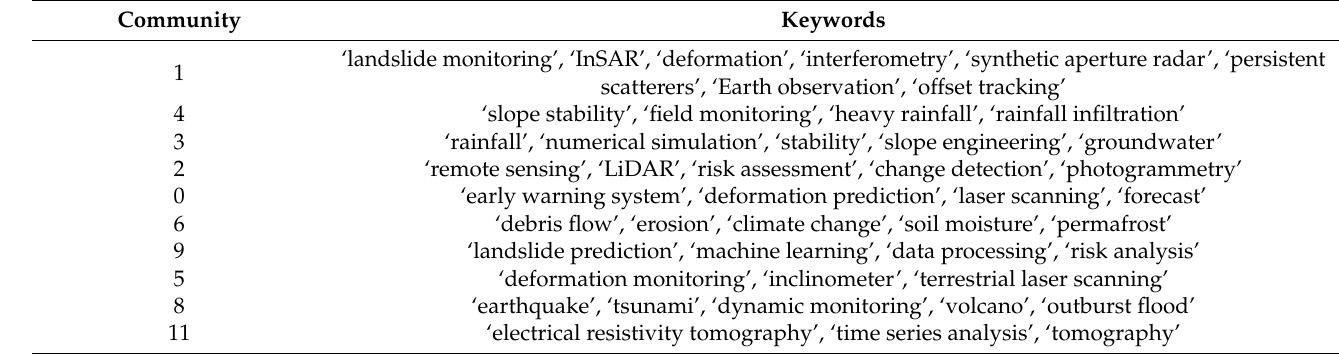
Table 3. Keywords associated with the landslide monitoring communities (K ≥